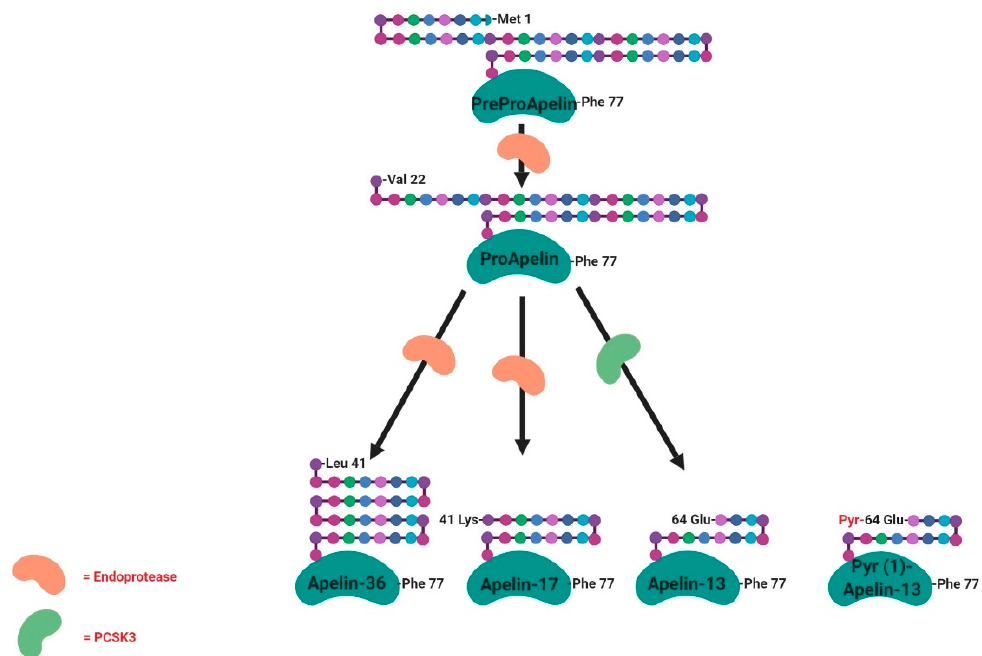
Figure 4. Structure and specific forms of human apelin. Human apelin is first of all found under the preproapelin form (77 amino acids) that will be cleaved by endopeptidases acting on basic amino-acid-rich regions giving the proapelin (55 amino-acids) and then the other tissue-dependent active isoforms (36, 17, 13 and Pyr-13 amino-acids). PCSK3 (proprotein convertase subtilisin / kexin 3) is involved in the cleavage of proapelin to apelin-13.